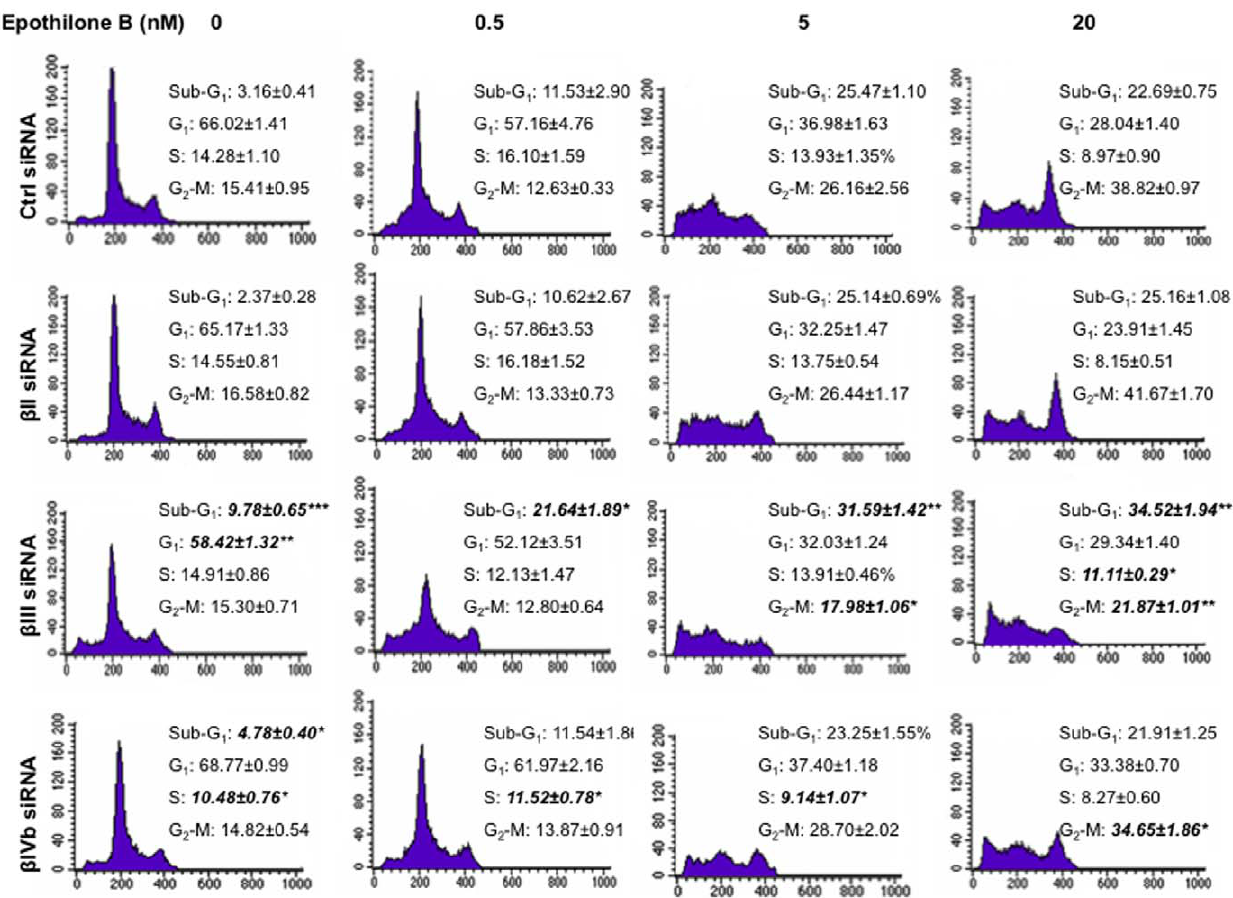
Figure 2. Cell cycle analysis of H460 knockdown cells treated with epothilone B. Drug concentrations were indicated on top of the figure. Cells were harvested after 24 h drug treatment and subsequently assayed for their DNA content by flow cytometry as described in Materials and Methods. Representative figures of four independent experiments are shown. * P , 0.05, ** P , 0.01.